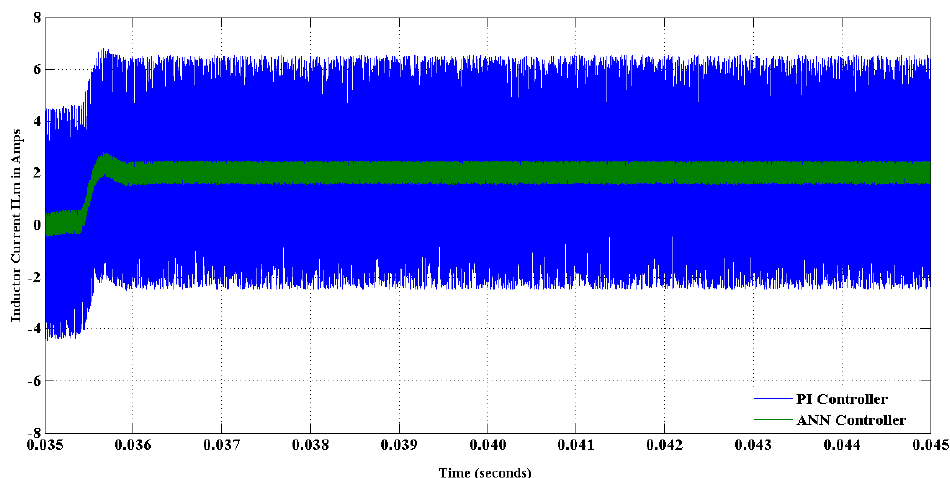
Figure 22. Regulated current step variations in inductor currents at dual low voltage sources.